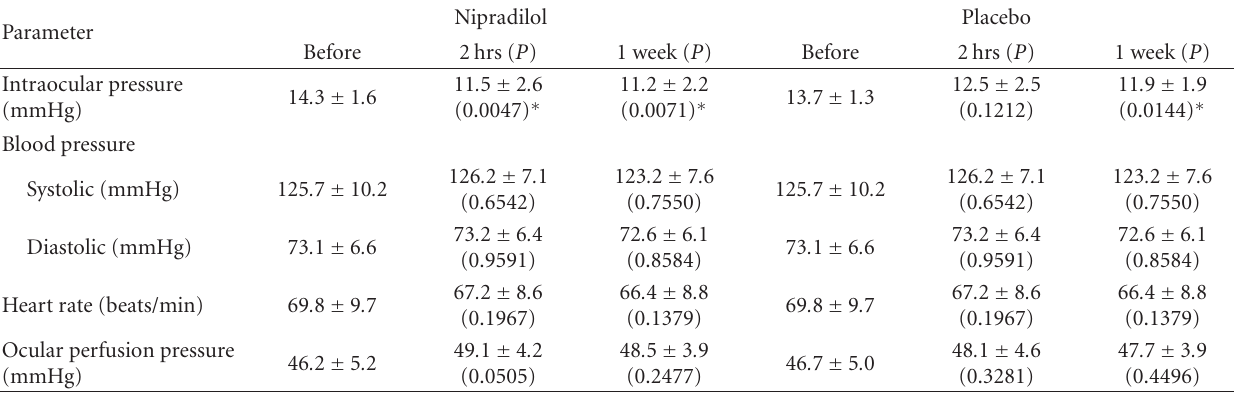
Table 1: Systemic and ocular parameters before and after topical application of nipradilol or placebo in controls.